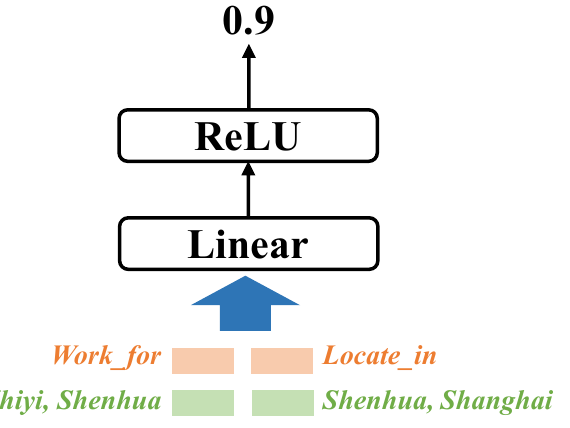
Figure 4. The details of the score operation in Figure 3. The orange box and the green box are concatenated to be a triple representation. Two triples are used to compute the probability to infer a new